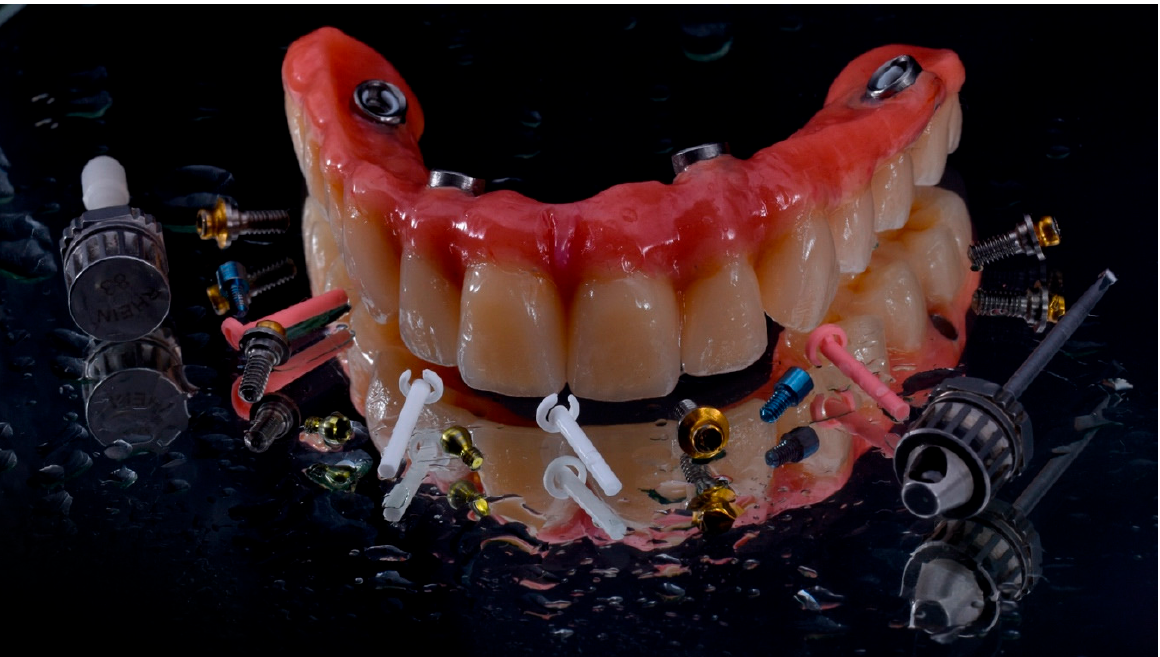
Figure 17. Particulars of all the components used in the prosthesis.